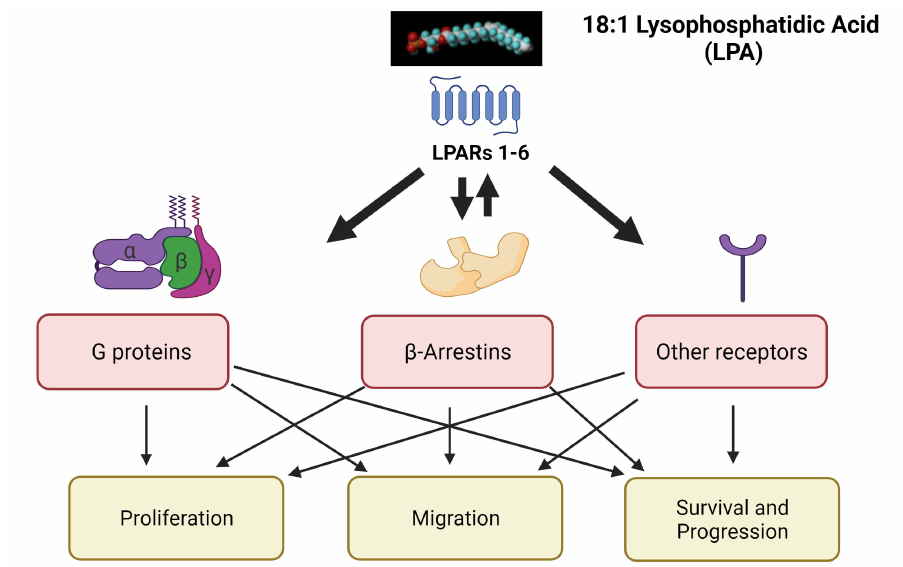
Figure 1. Pathways for LPA-mediated signal transduction in cancer cells. Although 18:1-LPA is depicted here, it is not the only species of LPA with biological activity. LPA can activate any of the six confirmed LPA receptors (LPARs) in the plasma membrane. These receptors interact with G proteins, β -arrestins, and/or other membrane receptors to transduce signals that enhance cell proliferation, migration, and survival. β -Arrestins also play a role in desensitizing receptor activity via GPCR internalization. Partnering receptors can either enhance LPA production and LPAR activity (e.g., EGFR, CD97) or inhibit LPAR activity (e.g., FFAR4). This figure was made using www.biorender.com; accessed 4 August